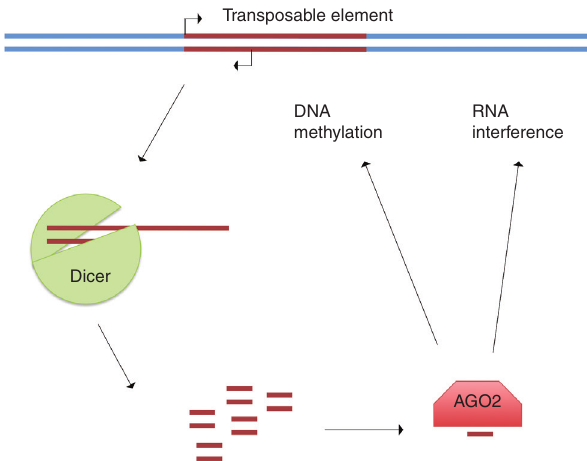
Figure 3 TE silencing via sRNA